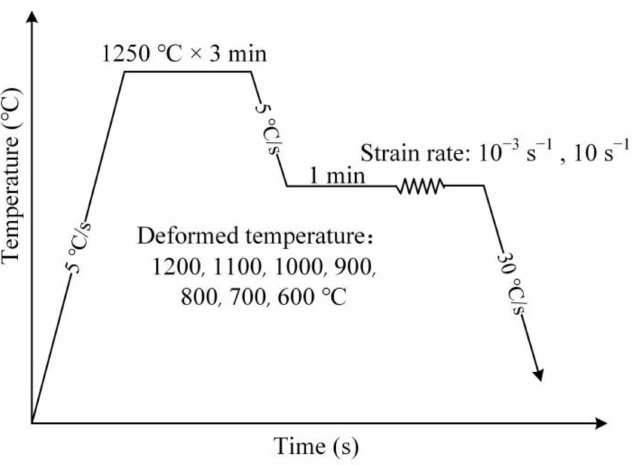
Figure 1. The experimental